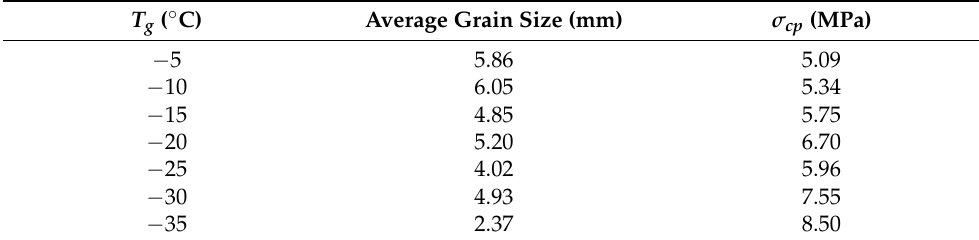
Table 4. Result of grain size